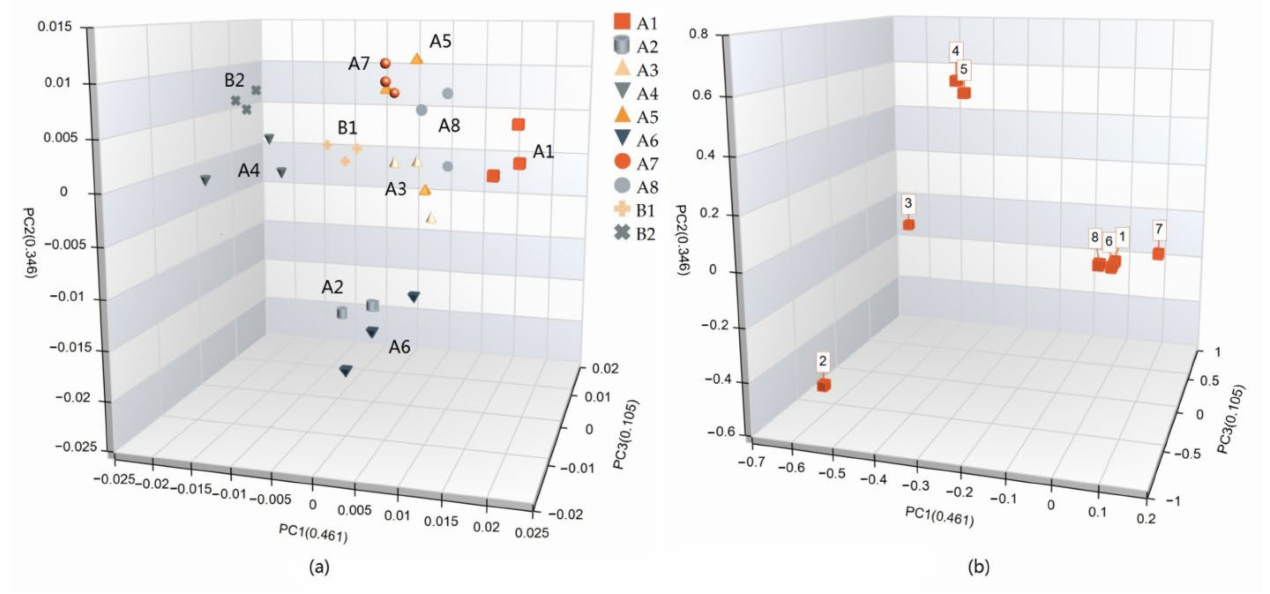
Figure 6. ( a ) Separation of the 10 groups in PCA space based on the data of E-tongue; ( b ) distribution of 8 sensor responses in the 10 groups (numbers correspond to those in Figure